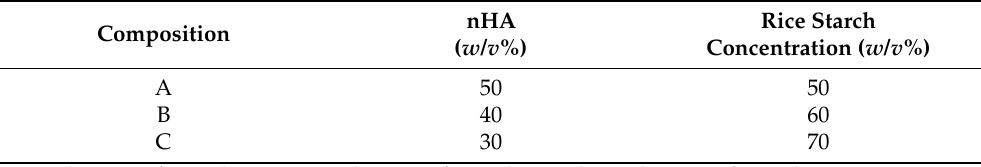
Table 1. Weight/volume percentages ( w/v %) of nHA and Wangi rice starch used to fabricate the scaffold. nHA Rice Starch Composition ( w/v %) Concentration ( w/v %) A 50 50 B 40 60